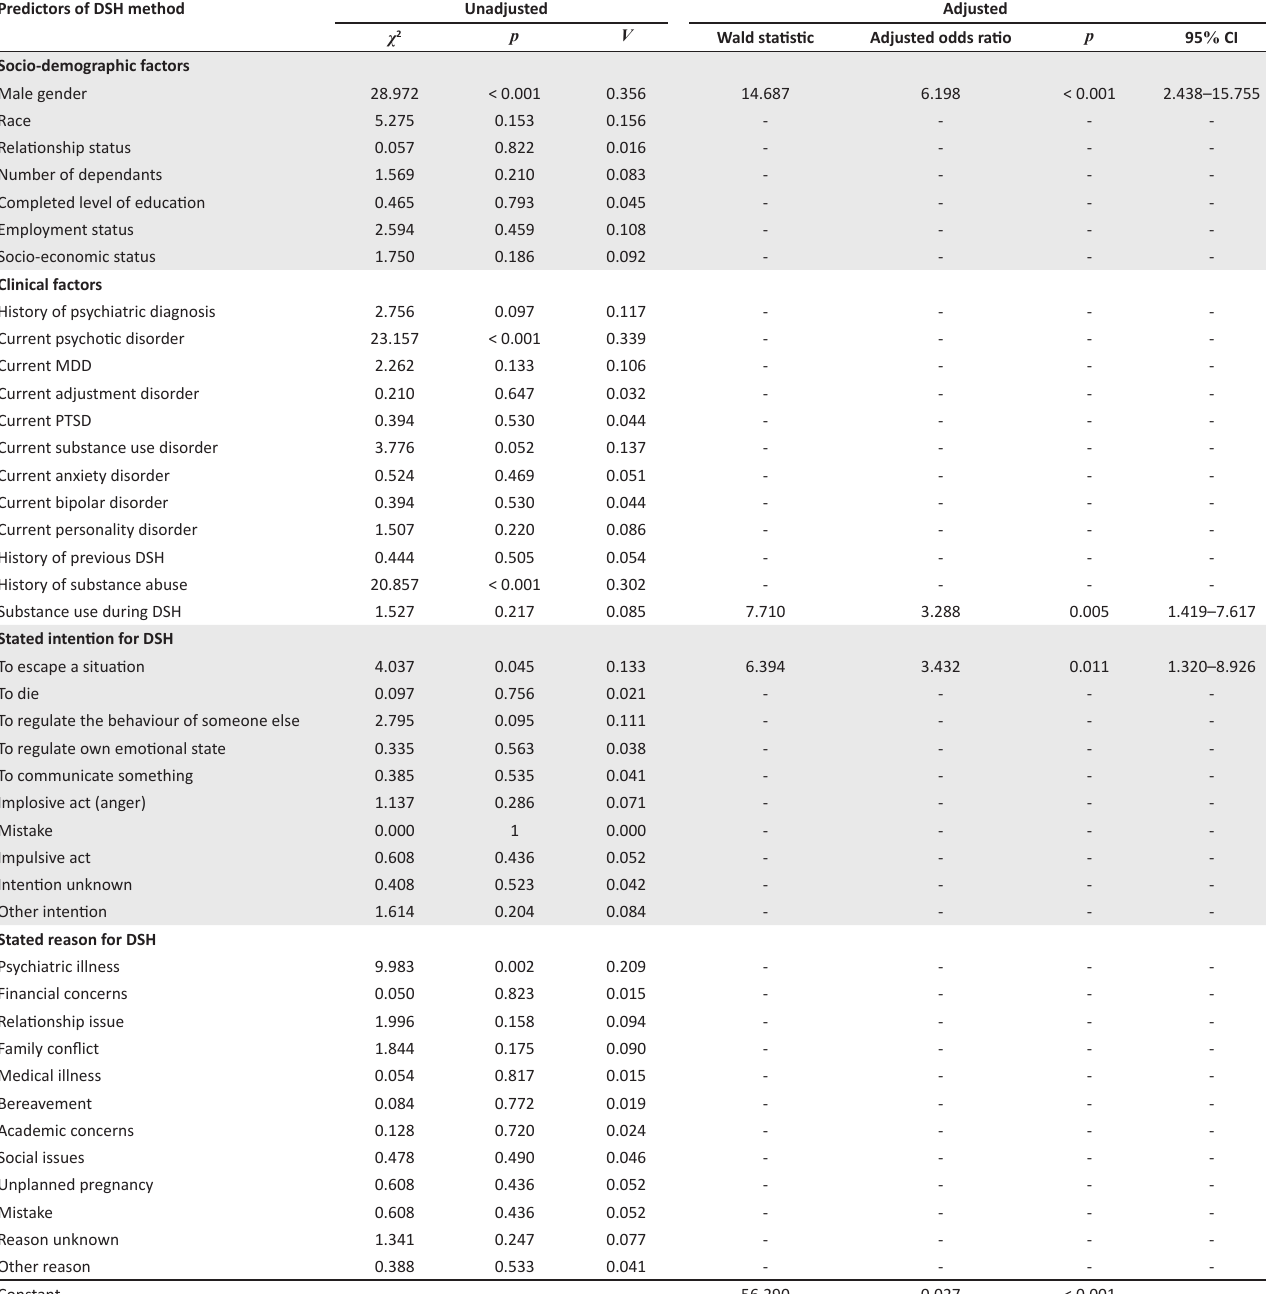
TABLE 4: The unadjusted and final regression coefficients form the bivariate and motivate analysis of factors associated with method of self-harm. Predictors of DSH method